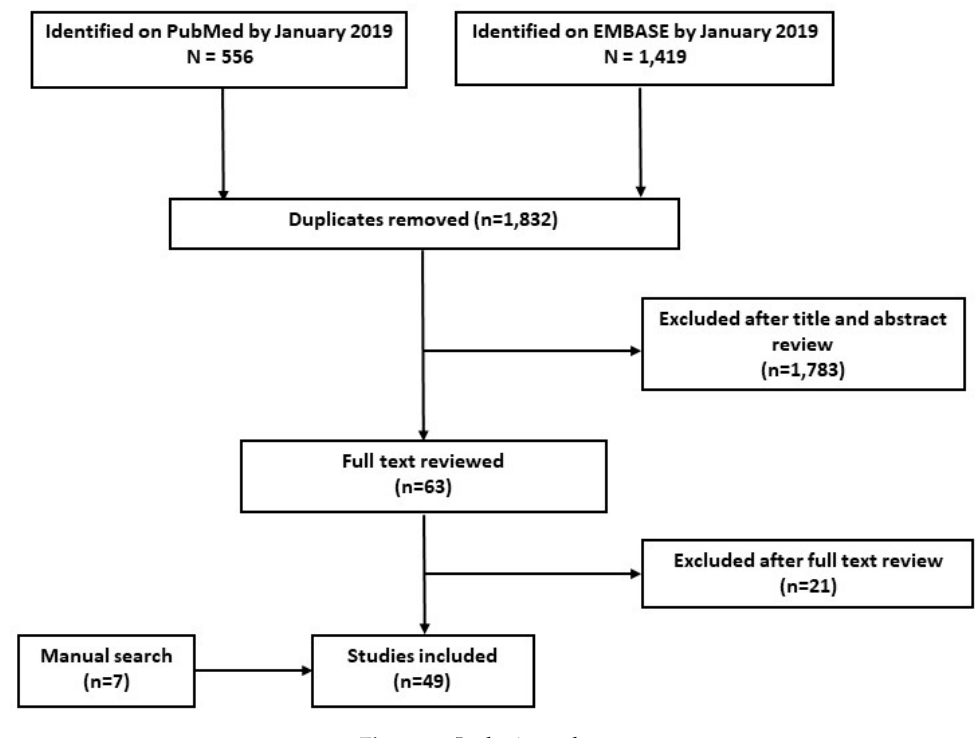
Figure 1. Inclusion schema.